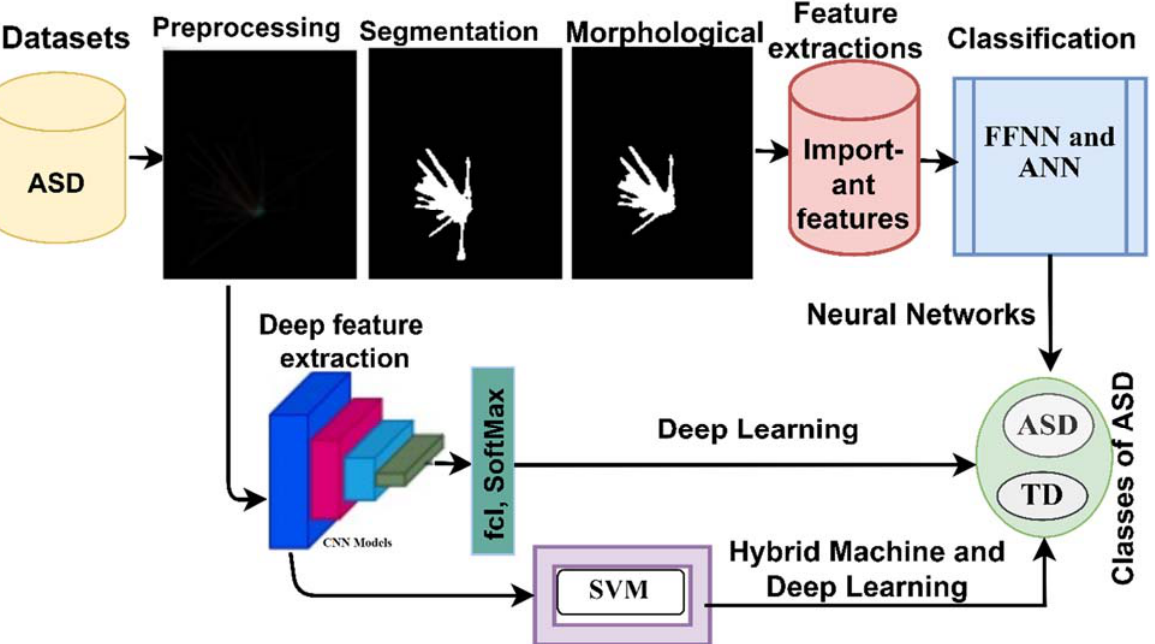
Figure 1. Methodology for diagnosing ASD datasets by using the proposed systems.